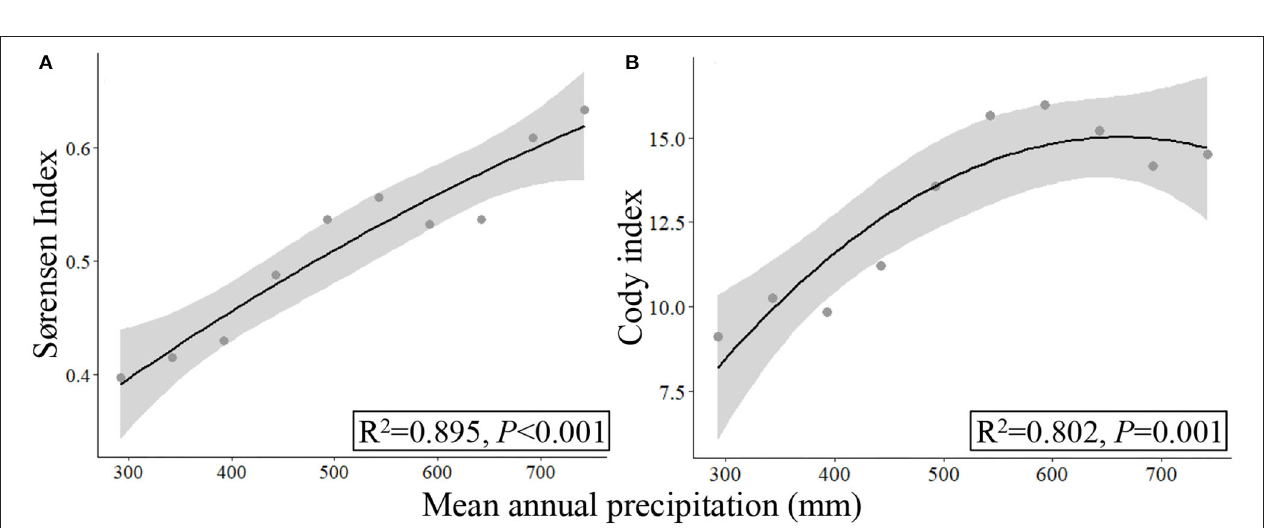
diversity could be explored using the longer time-sequenced data of species diversity collected by FragMAP system (Zhang et al., 2021) at a large region in the future